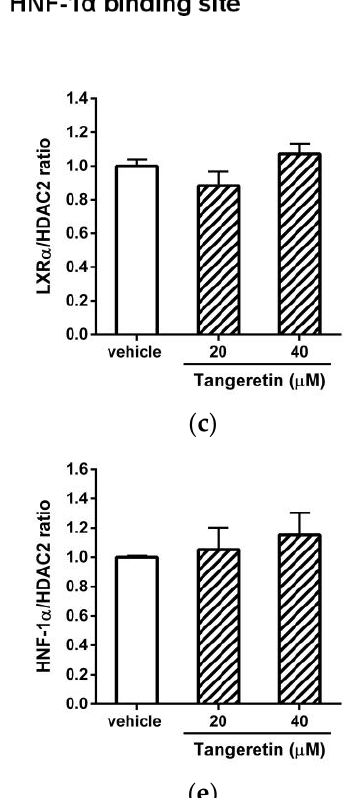
Figure 7. Effects of tangeretin on nuclear LXRα and HNF-1α proteins. ( a ) Analysis of the tangeretin-responsive element within the ANGPTL3 promoter (−250/−121). The DNA sequences identified by the binding of the transcription factors LXRα and HNF-1α are indicated as the LXRα-binding site and HNF-1α-binding site, respectively. ( b ) HepG2 cells were treated with vehicle (0.1% DMSO) or tangeretin (20 and 40 μM) for 24 h. The level of nuclear LXRα protein was analyzed by Western blot analysis. A representative blot is shown. ( c ) The normalized intensity of LXRα versus HDAC2 is presented as the mean ± SD of three independent experiments. ( d ) The level of nuclear HNF-1α protein was analyzed by Western blot analysis. A representative blot is shown. ( e ) The normalized intensity of HNF-1α versus HDAC2 is presented as the mean ± SD of three independent experiments.